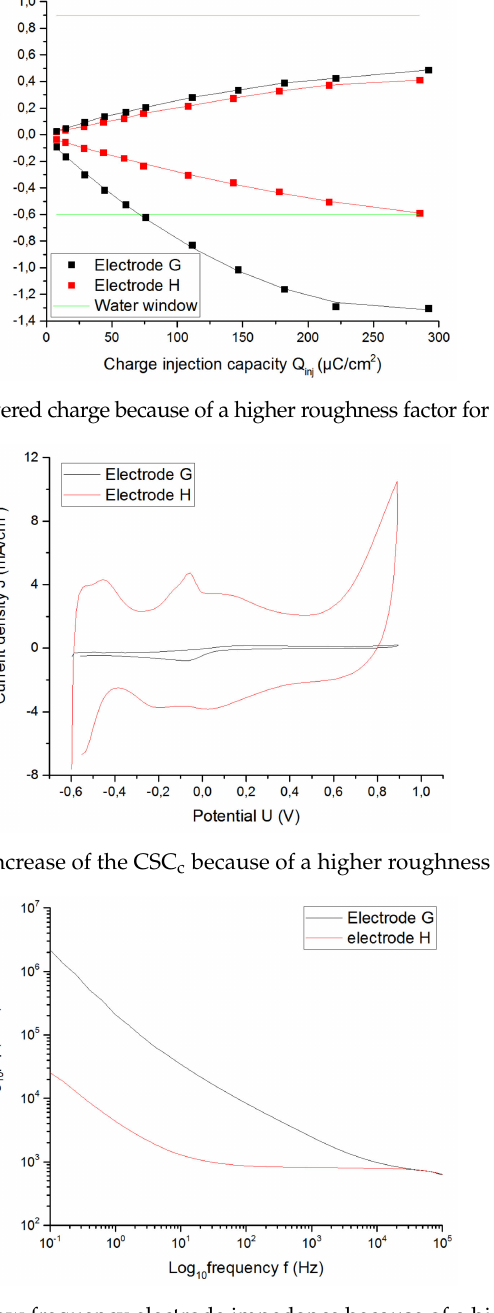
Figure 11. Decrease of the low frequency electrode impedance because of a higher roughness